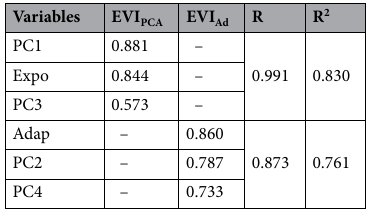
Table 6. Linear regression